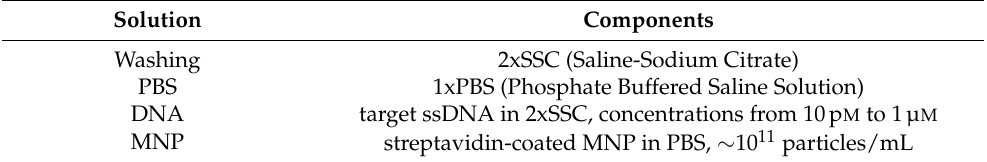
Table 3. Solutions used for the hybridization.